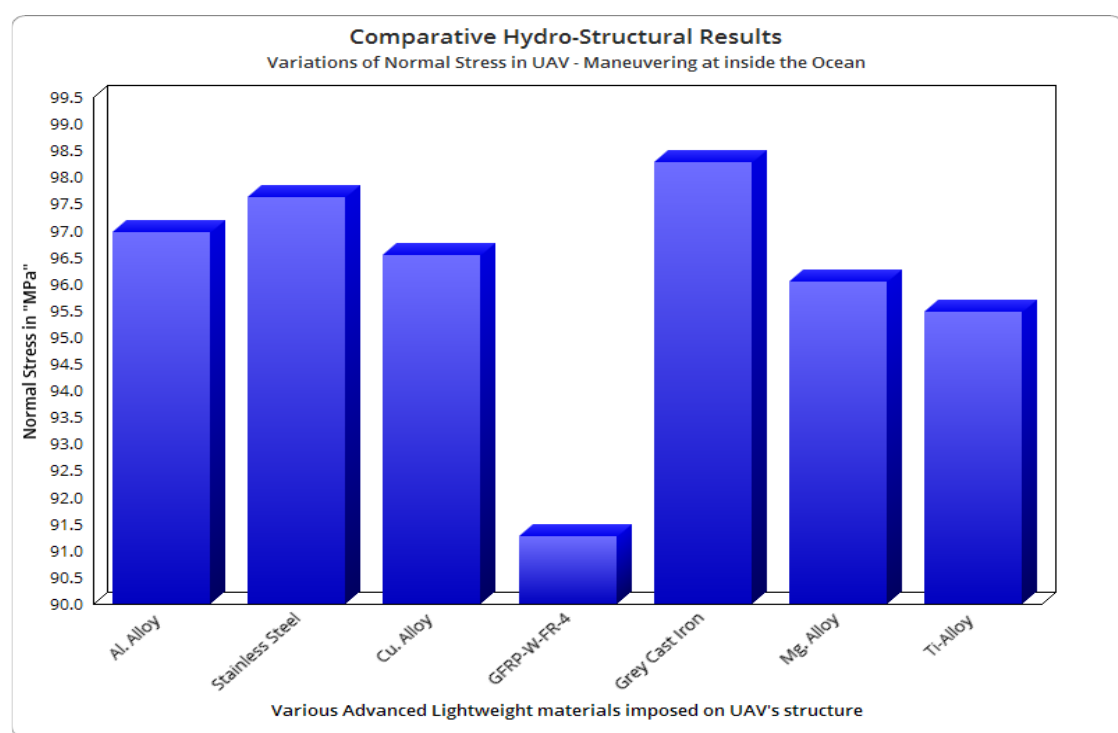
Figure 39. Comparative normal stress variations for various lightweight materials.